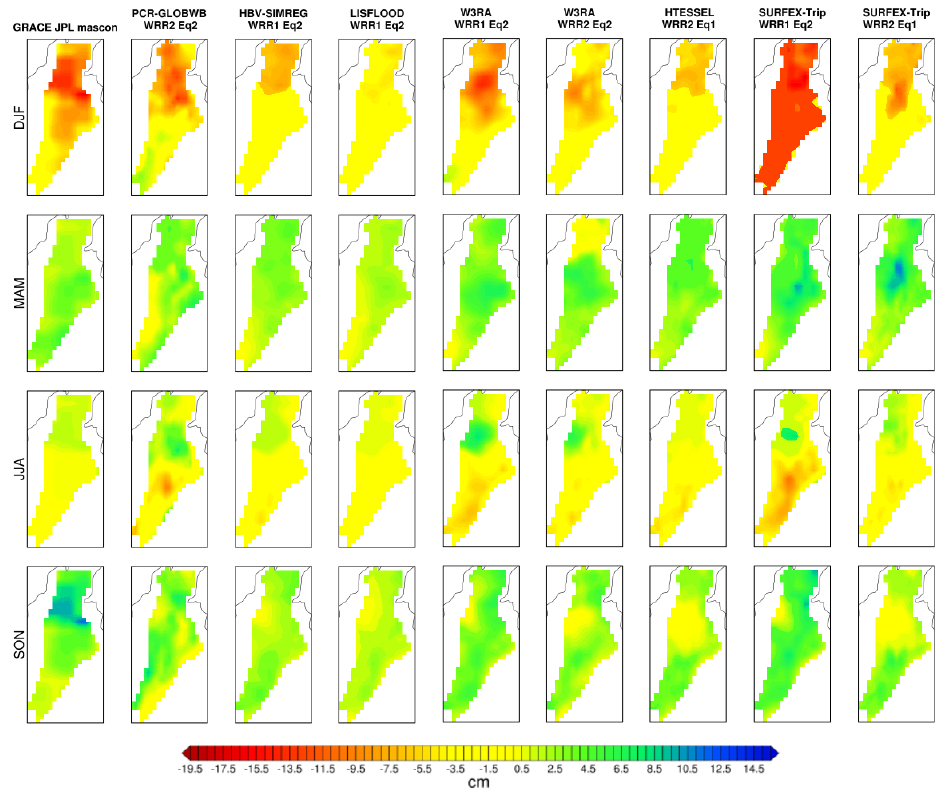
Figure 7. Seasonal maps for GRACE JPL, GHM, and